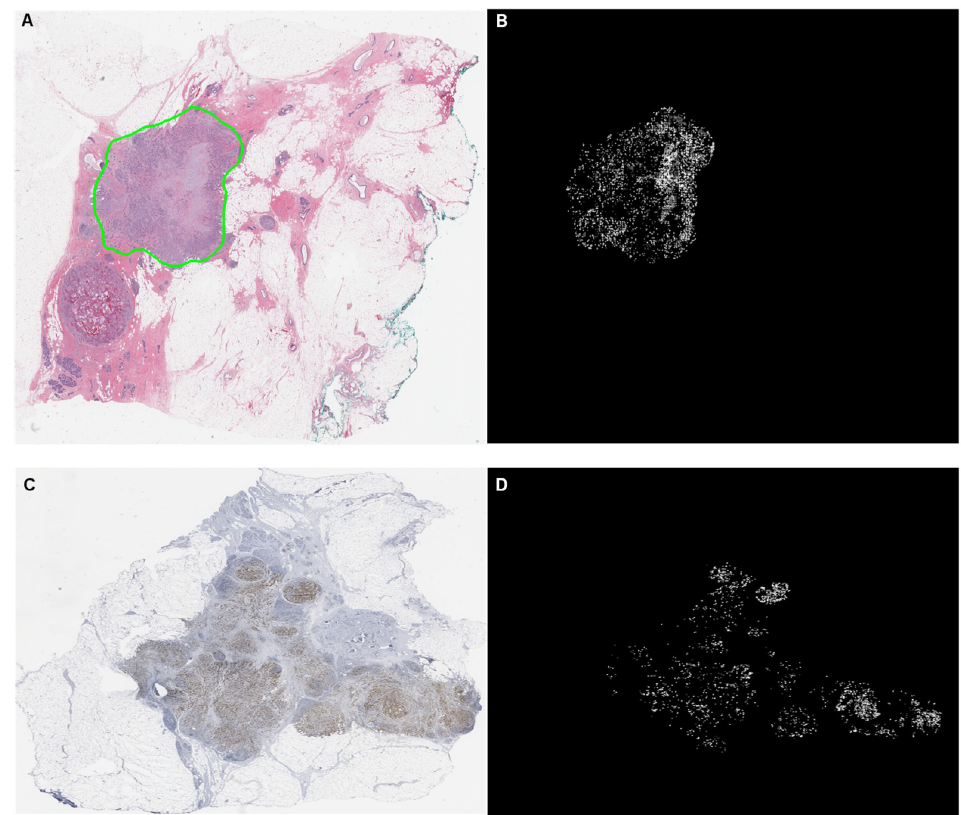
Fig 10. Heatmap visualization of the attention weights yielded by the attention based MIL model. The top row are a thumbnail and corresponding heatmap of an H&E slide. The bottom row are a thumbnail and corresponding heatmap of a Ki67 slide. The heatmaps are contrast enhanced for visualization purpose. The bright area in the heatmaps correspond to WSI area that receive high attention